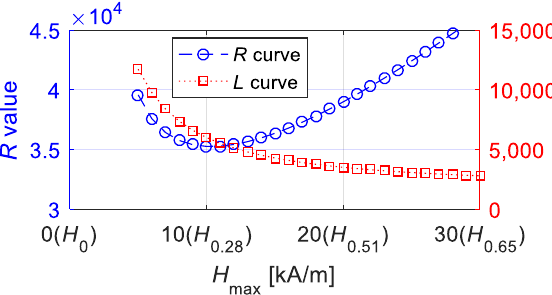
Figure 8. Optimal values of R and L under fixed parameters of k = 2 kA/m, a = 12 kA/m, c = 0.2, α = − 0.001 and M s = 80 kA/m during different amplitudes of magnetic field intensity (the Abscissa axis gave the values of amplitude and r value of H r simultaneously).